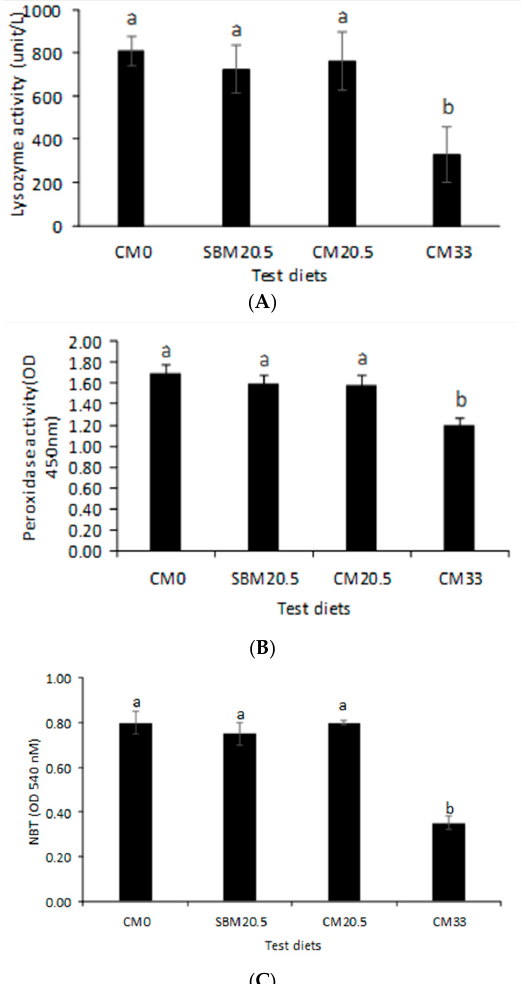
Figure 1. ( A ) Serum lysozyme activity (U/L, n = 3); ( B ); serum peroxidase activity ( n = 3); ( C ) nitro blue tetrazolium (%, mean ± standard error, n = 3) of nutrients in red seabream fed diets formulated by replacing fish meal with camelina meal at 0% for reference diet (CM0), 20.5 g/kg with soybean mean (SBM20.5), 20.5 g/kg with camelina meal (CM20.5) and 33 g/kg camelina meal (CM33).Values with different letters are significantly different ( p < 0.05).